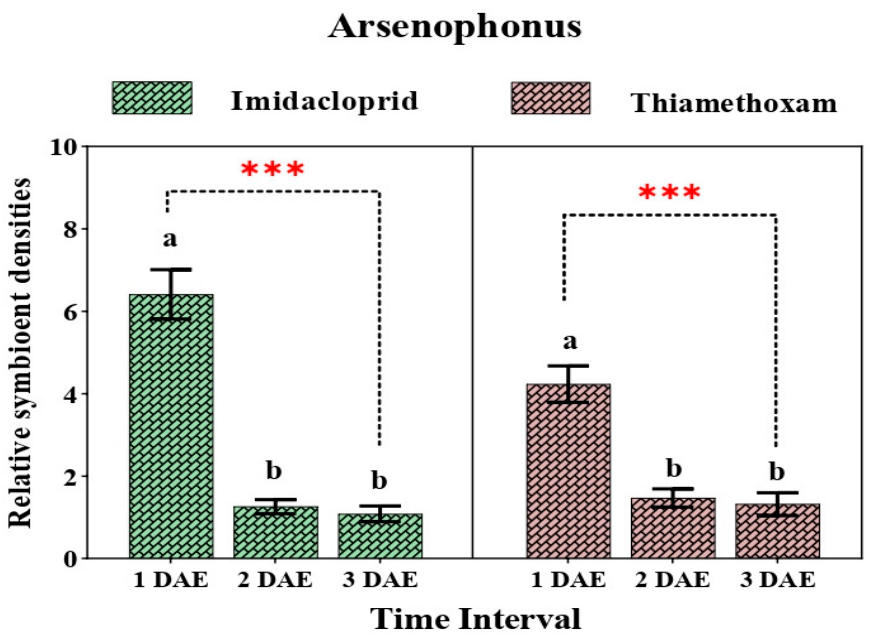
Figure 4. Relative density of Arsenophonus in whiteflies after exposure to sublethal doses of im- idacloprid 17.8 SL and thiamethoxam 25 WG at various durations (1 DAE, 2 DAE, and 3 DAE). Bars represent the standard error of the mean (SEM), and the different letters indicate statistically significant differences between the treatments. p ≤ 0.001 is indicated by ***. DAE, days after exposure.